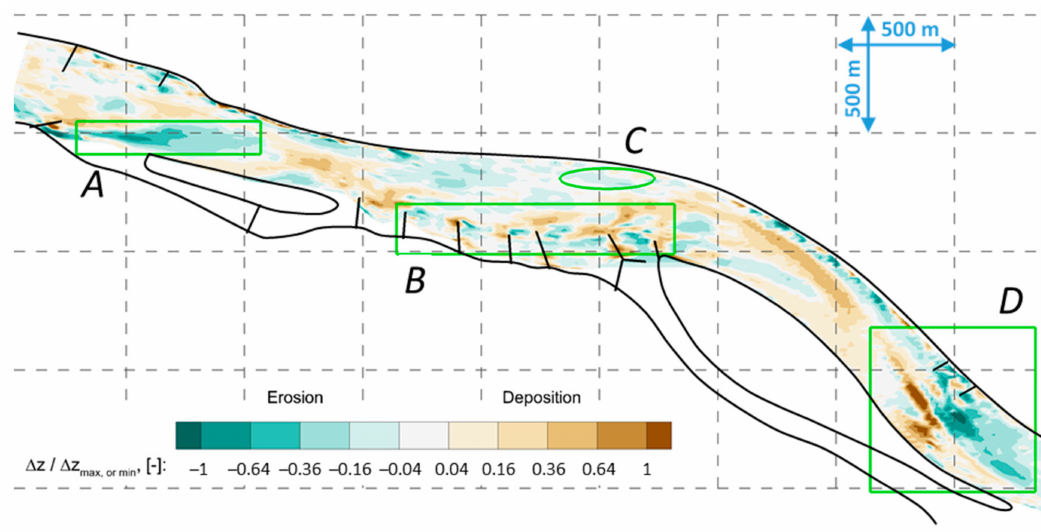
Figure 12. Normalized bed changes of the measured values (Figure 4) regarding the whole period October 2012–October 2014.